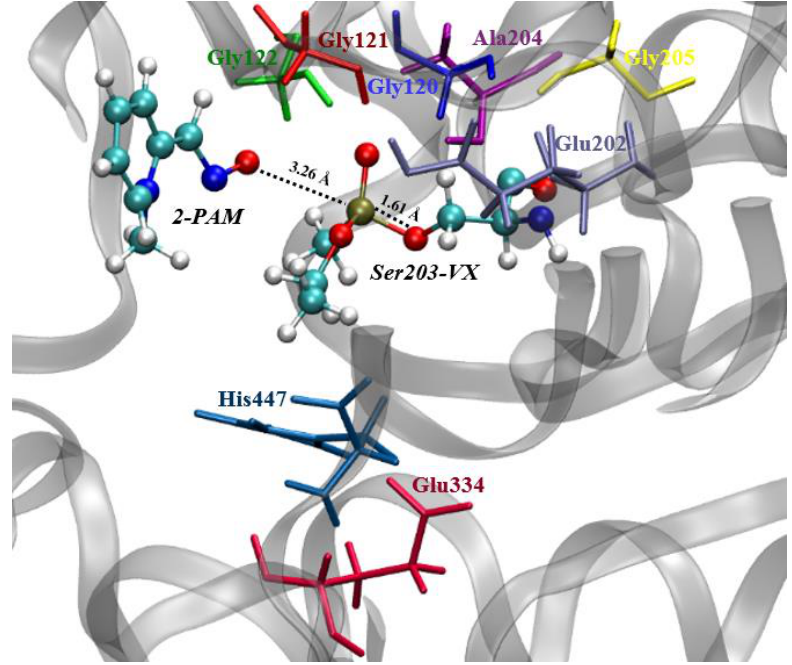
Figure 3. QM system (coloured atoms) after geometry optimization of the NAC frame.